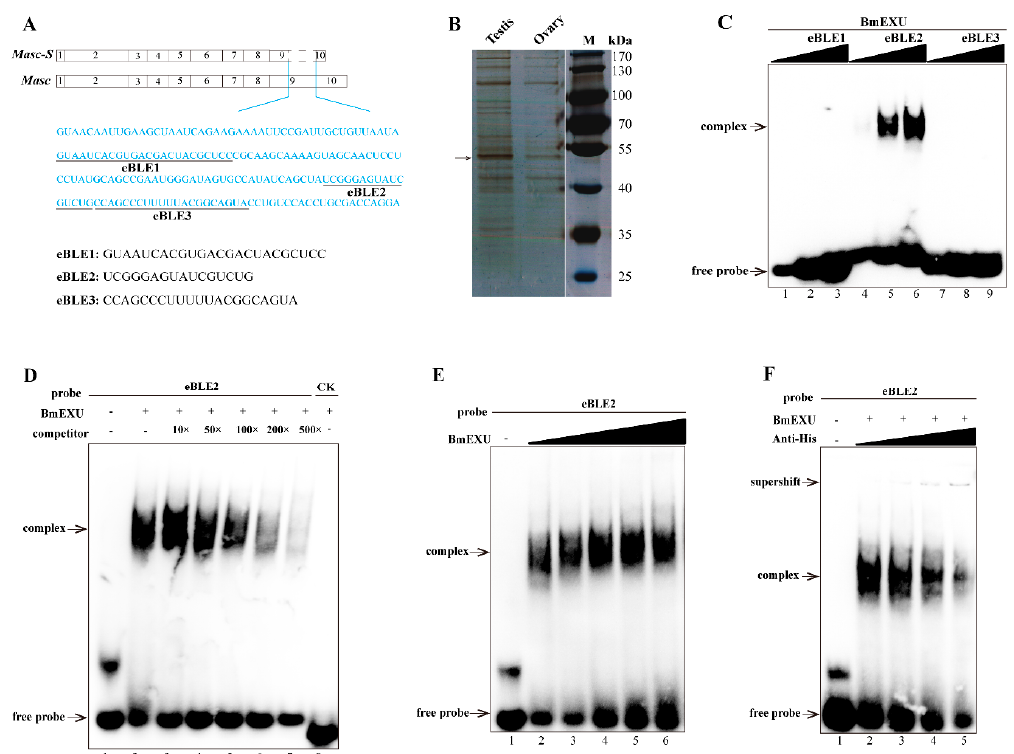
Figure 4. Identification of the protein specifically binding to the exclusive RNA sequence in Masc compared to Masc-S . ( A ) The exclusive RNA sequence (blue characters) in Masc was showed. In the exclusive sequence, there is three elements similar to the binding-like element 1 (BLE1) of Drosophila bcd gene, and we named three elements as eBLE1, eBLE2 and eBLE3. ( B ) SDS-PAGE with silver staining showed the proteins pulled down by the exclusive RNA from nucleoprotein extract from testis and ovary of day 5 fifth instar larvae. The different band (arrow) was excised from the gel for following LC/MS/MS analysis. MS/MS spectra were searched against the protein database, which resulted in the identification of 14 candidate binding proteins including Bombyx mori exuperantia (BmEXU) protein (Supplementary Table S2). In Drosophila , the EXU protein functions in the germline by binding the sequence of BLE1 in the bcd mRNA. ( C ) EMSA of the biotinylated probes (eBLE1, eBLE2 or eBLE3) and nucleoprotein extract from BmE with overexpression of the BmEXU protein was carried out. In order to verify whether the BmEXU protein binds to the exclusive RNA sequence in Masc compared to Masc-S, we performed EMSA of the BmEXU protein and three elements (eBLE1, eBLE2 or eBLE3) in the exclusive RNA sequence. The amount of RNAs (100, 200, 500 nmol) for each probe was incubated with nuclear extract (1.2 µ g) for 20 min, respectively. ( D – F ) Gel-shift assay of the BmEXU protein and the eBLE2 RNA probe was performed to verify the specific binding of the protein to the probe. ( D ) The binding assays of BmEXU nuclear extract (1.2 µ g) to the probe eBLE2 (150 nmol) with 1-, 10-, 50-, 100-, 200-, 500-fold excess cold probes (lanes 2–7) and an irrelevant probe as control check (lane 8: CK) were shown. ( E ) Di ff erent concentration of the BmEXU protein (lanes 1–6: 0, 0.6, 1.2, 1.8, 2.4, 3.6 µ g) were incubated with eBLE2 (150 nmol). ( F ) Di ff erent concentration of anti-His-tag antibody (lanes 2–5: 0, 0.2, 0.5, 1.0 µ L) incubated with eBLE2 (150 nmol) and BmEXU nuclear extract (1.2 µ g). The recombinant His-tagged BmEXU protein was overexpressed in the BmE cells. The positions of the supershift, free and complexed RNAs are shown in